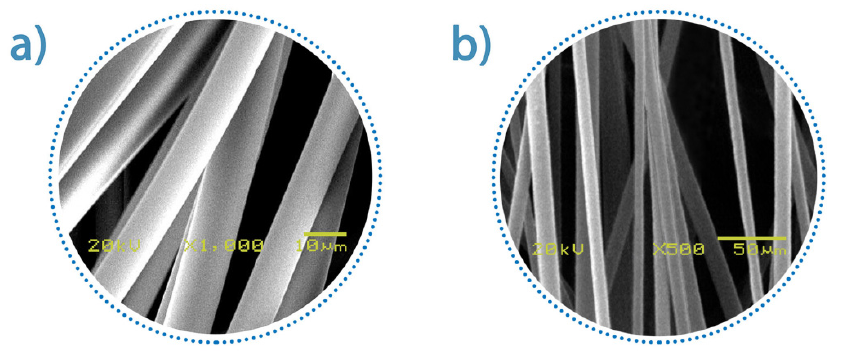
Figure 4. SEM image of contact-spun PVP 30 fiber ( a ), Magnification: 1000×, ( b ) Magnification: 500×.